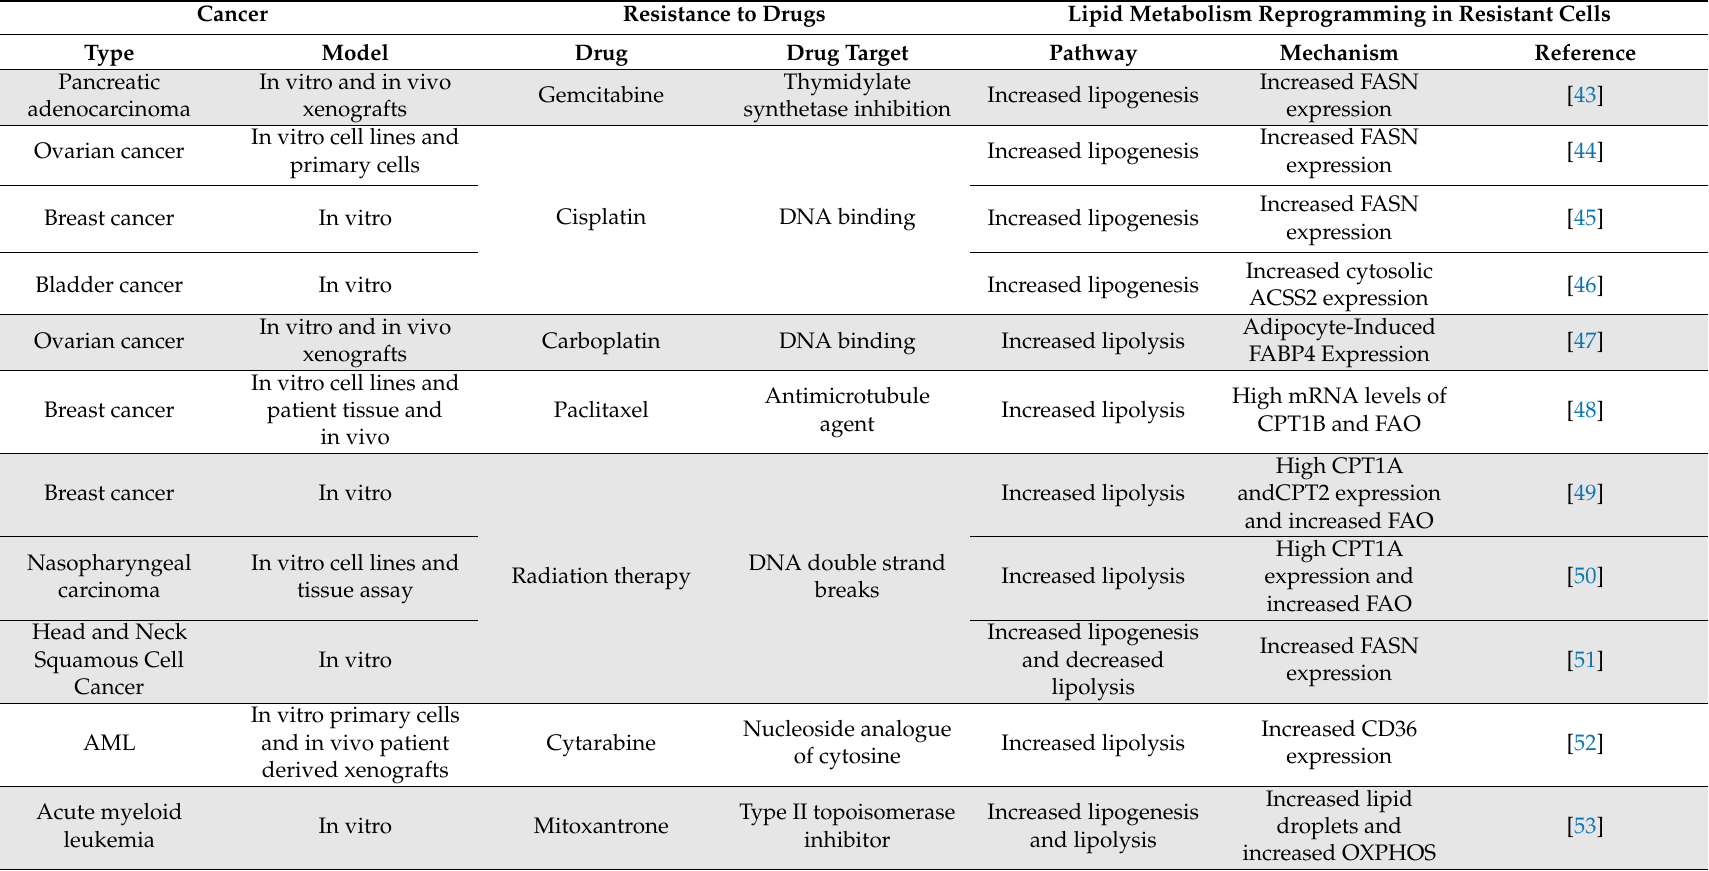
Table 1. Non-exhaustive list of changes in lipid metabolism associated with resistance to anticancer